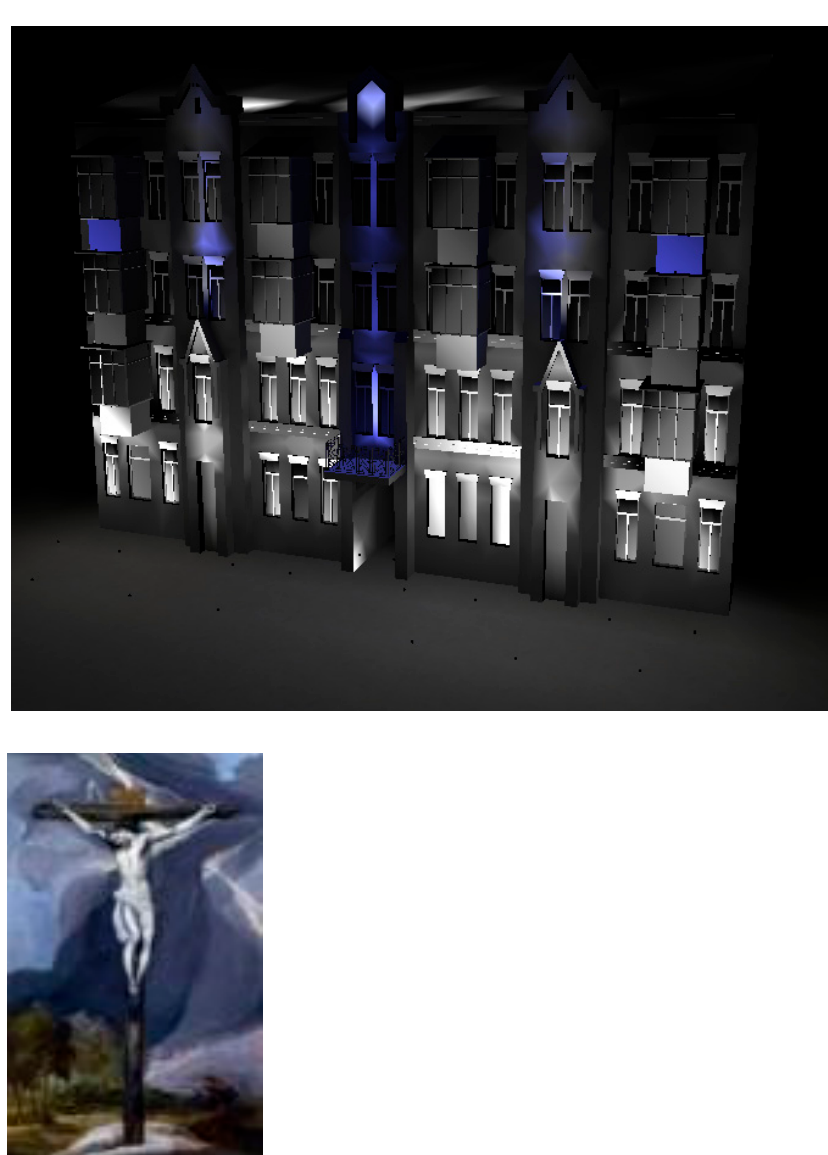
Figure 19. The working diagram for seasonal lighting of historical building façade (for Easter).